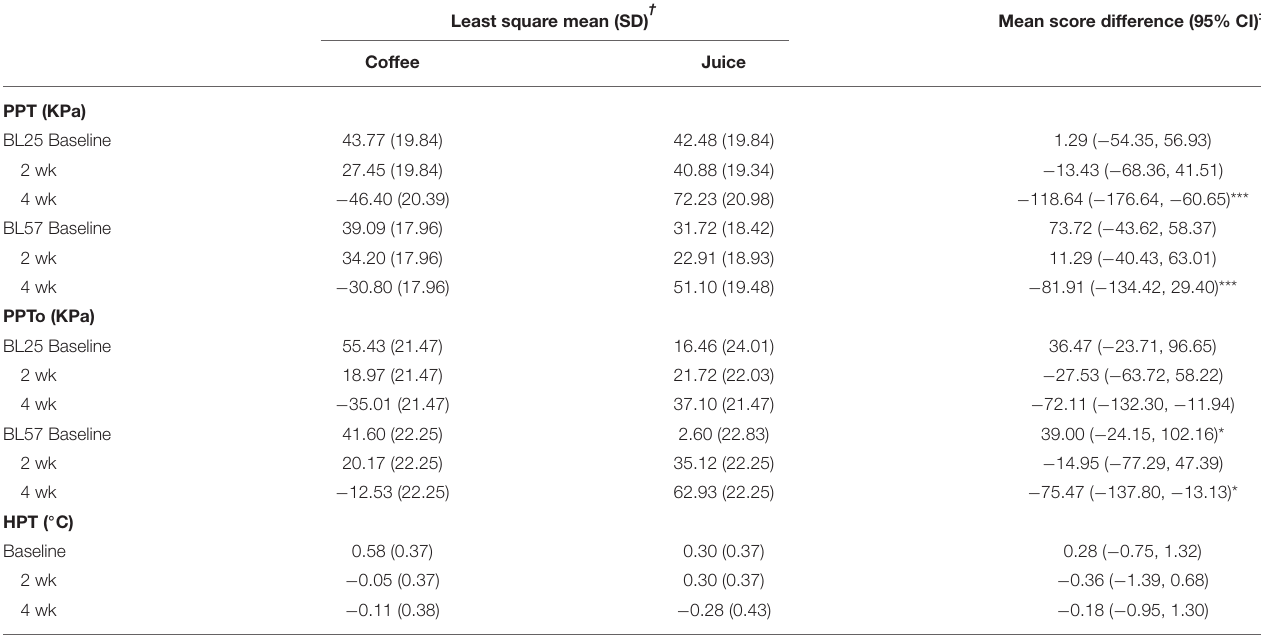
TABLE 1 | Static QST change.